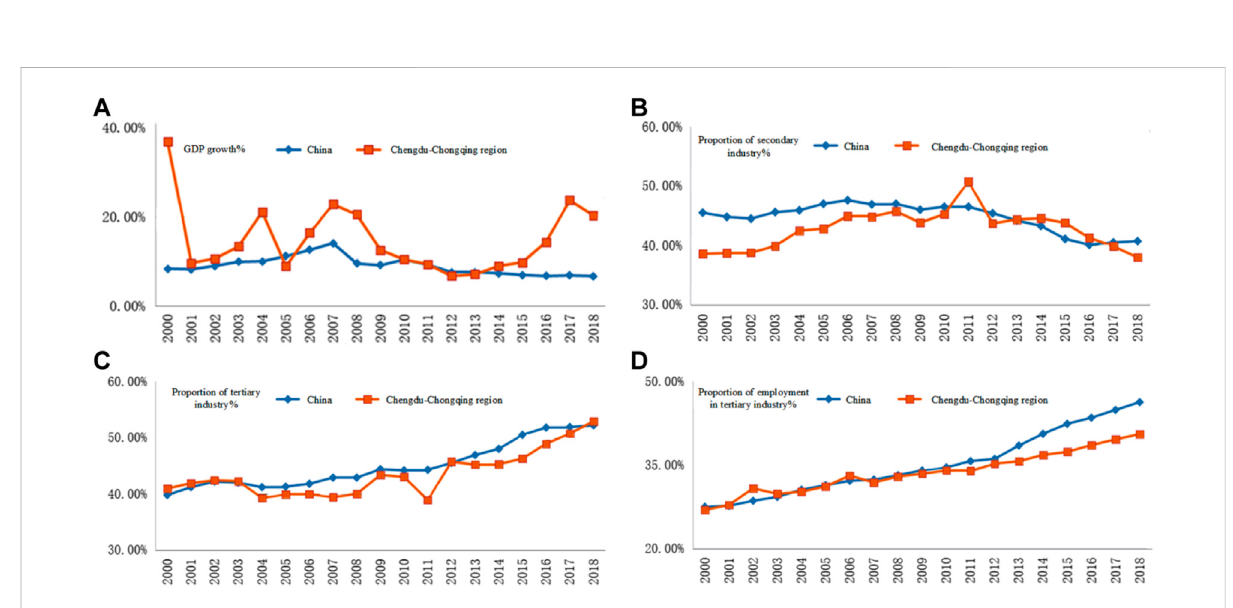
FIGURE 2 Main economic indicators in the Chengdu-Chongqing region, 2000 – 2018. (A – D) are respective the comparisons between the GDP growth rate, proportion of secondary industry, proportion of tertiary industry, proportion of employment in tertiary industry of Chengdu-Chongqing region and